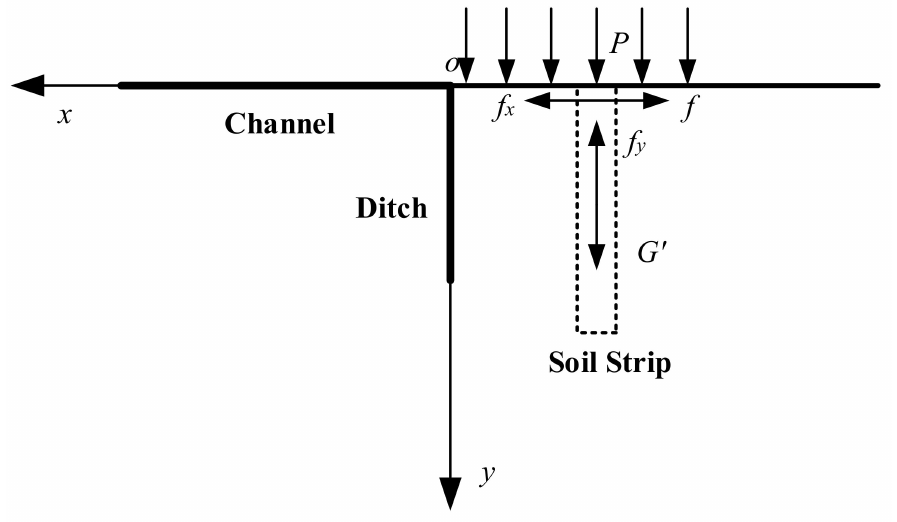
Figure 12. Schematic illustration of forces acting on any soil strip in front of the channel